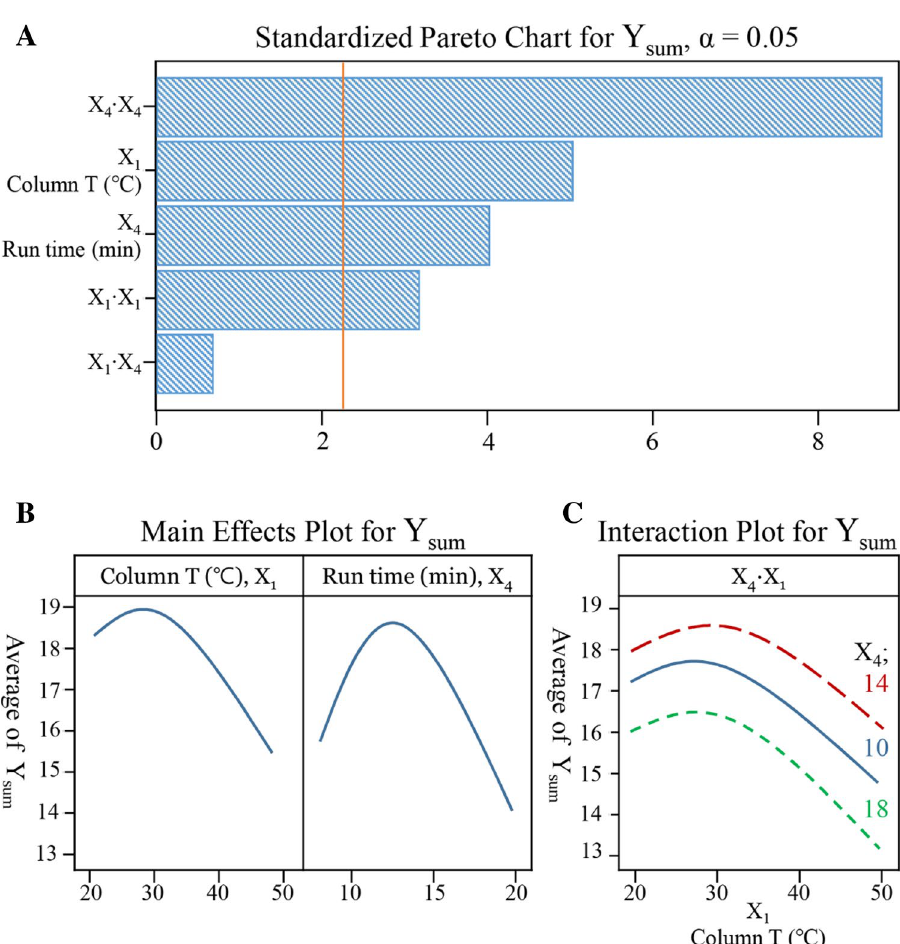
Figure 4. Pareto chart ( A ), main effect plots ( B ), and interaction plots ( C ) obtained during center composite design (CCD) studies of critical method attributes (CMAs), Y sum ; summarizes the eleven